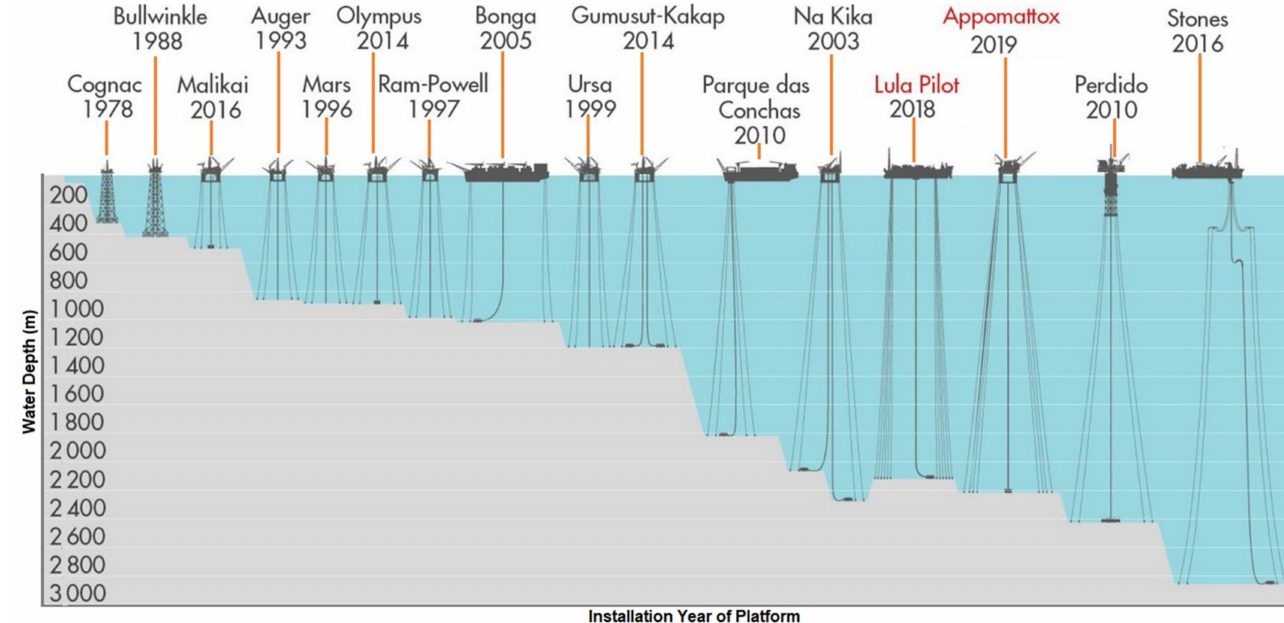
Figure A1. Historical development of deepwater platforms (Courtesy: Shell).